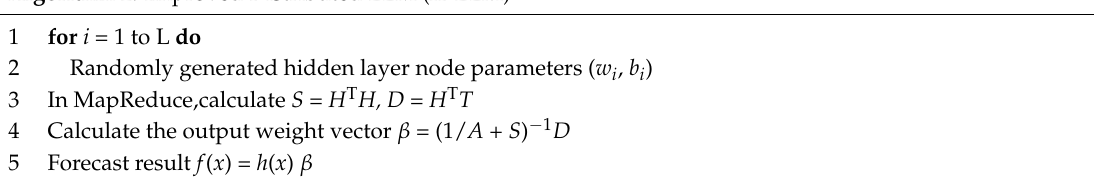
Algorithm 2: Improved Distributed ELM